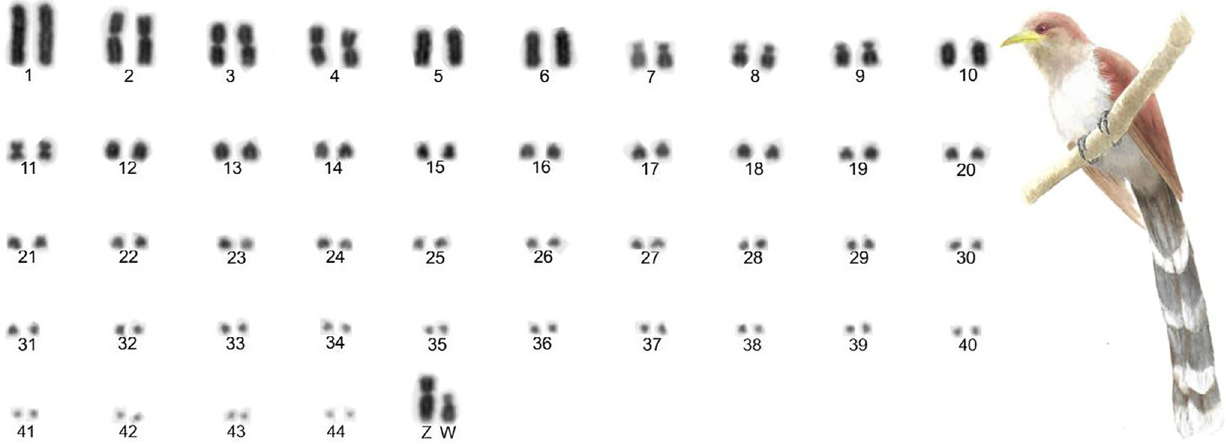
Fig 2. Complete karyotype of a female P . cayana (2n = 90), in conventional Giemsa staining.